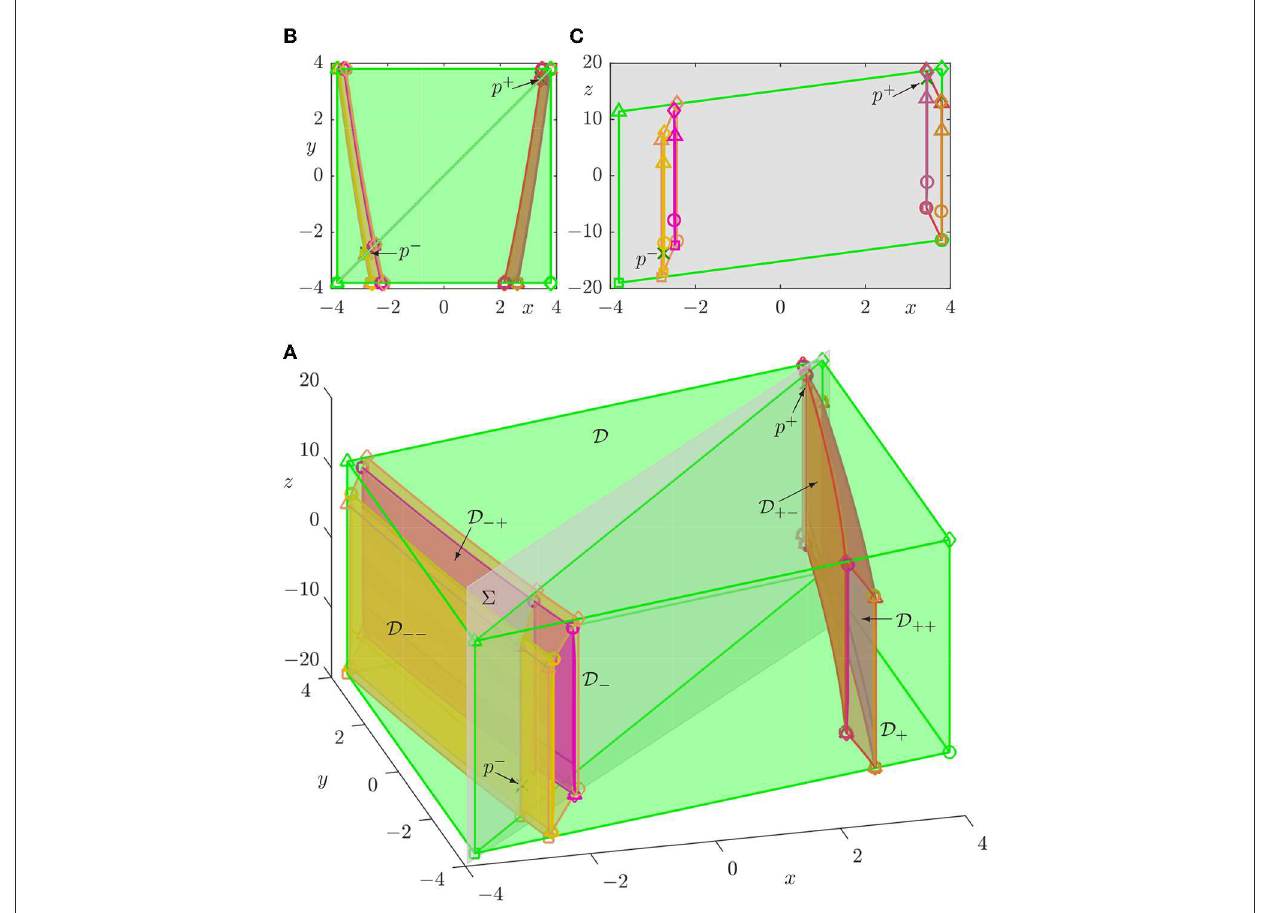
FIGURE7 Box D (green), its images D − (orange) and D + (red), and their images D −− (yellow), D −+ (magenta), D +− (dark magenta), and D ++ (light brown) under H with ξ = 0.8. (A) shows these objects in ( x , y , z )-space together with p ± (green crosses) and diagonal 6 (gray). (B) is the top view in the ( x , y )-plane, and (C) shows the intersecting parallelograms in 6 , which is represented by its projection onto the ( x , z )-plane. The y -aligned determining edges are labeled (cid:3) , △ , # , and 3 by their respective corner points, as defined for D in Equations (10)–(13). Compare with Figure 2.